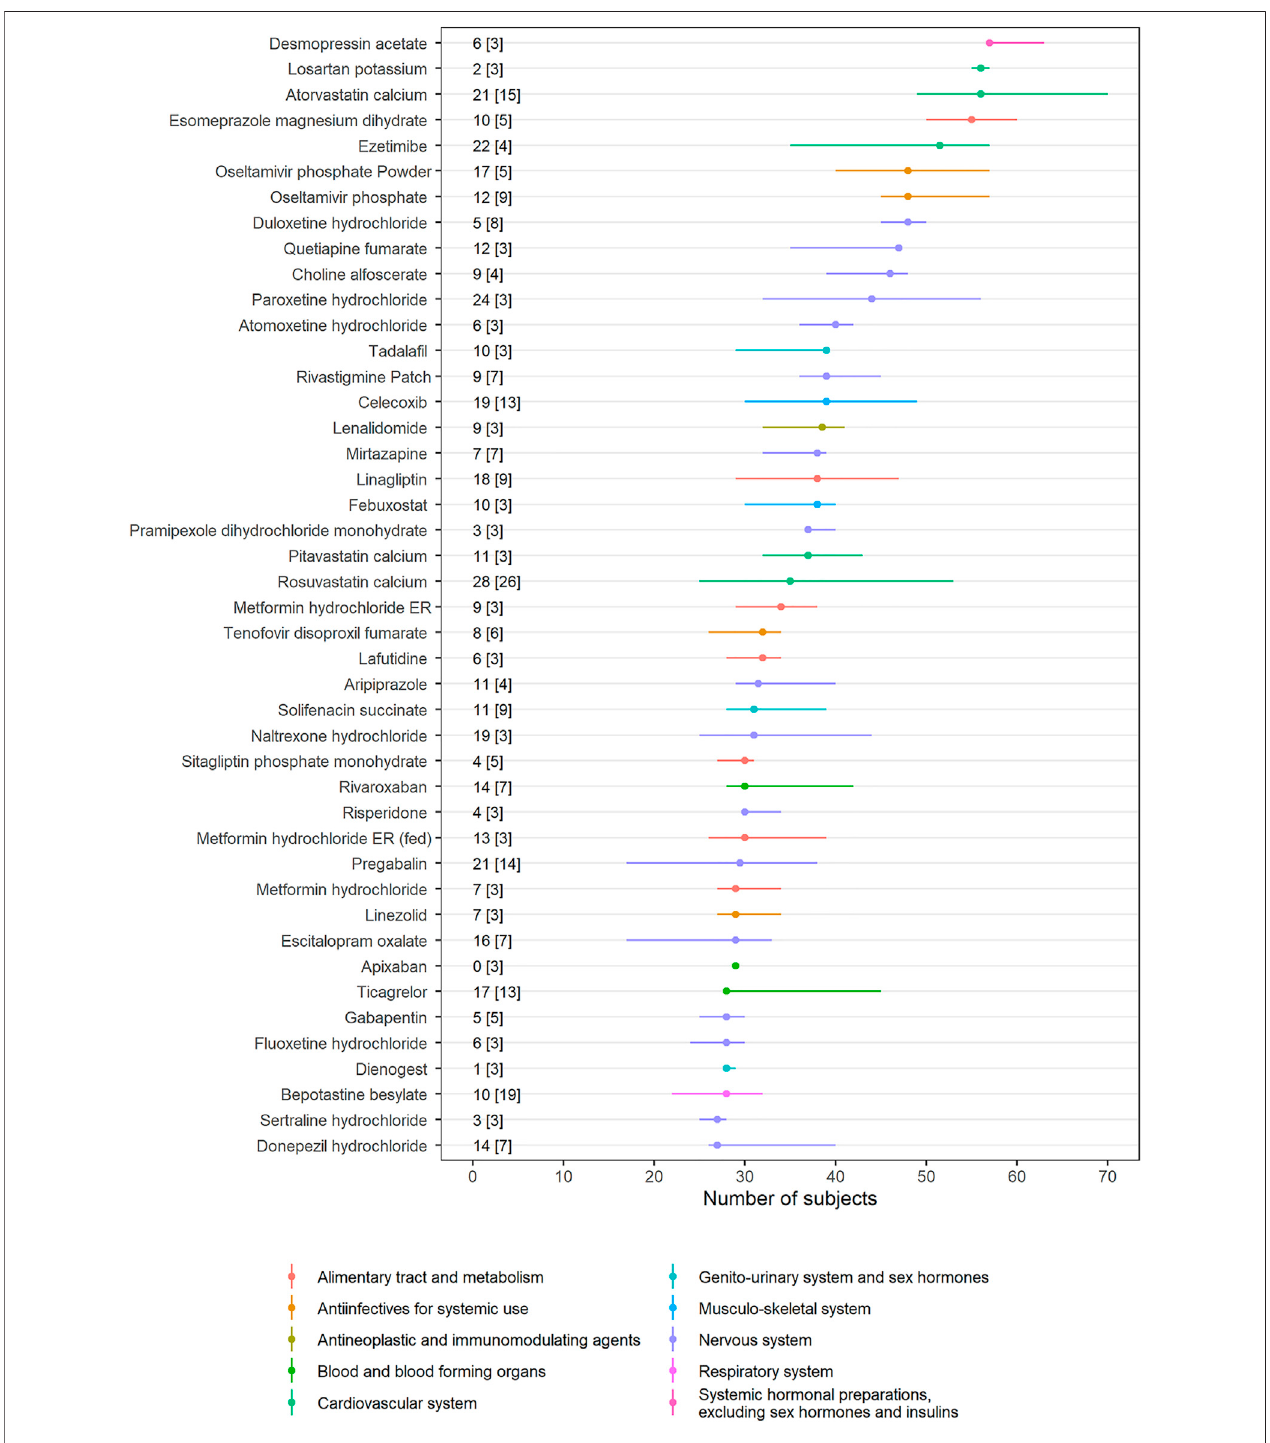
FIGURE2| Interstudyvariabilityofthenumberofsubjects.Dotsrepresentthemediannumberofsubjectsineachdrug,andhorizontallinesrepresenttheminimum and maximum number of subjects. The difference between the minimum and maximum number of subjects [the number of bioequivalence (BE) studies] is presented in the text. ATC classi fi cation for each drug is provided with colors (Notes: Drugs with more than three BE studies were selected. Fixed-dose combination drugs were excluded from the analysis. Only 2 × 2 BE trials are analyzed.).